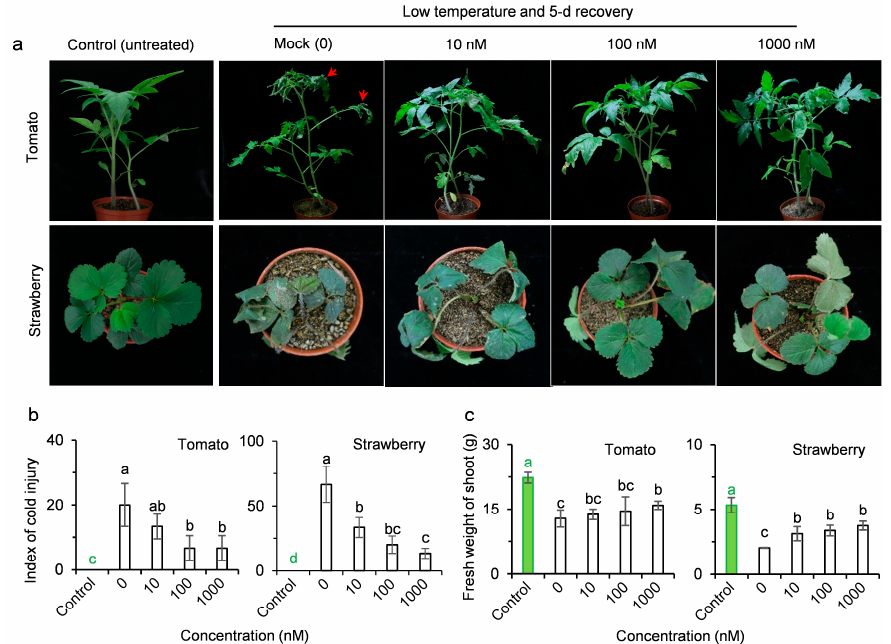
Figure 6. Induction of resistance to low temperature by AMHA in strawberry and tomato seedlings. After pretreatment with water containing 0.02% Tween-20 (mock) or different concentrations of AMHA (10, 100 and 1000 nM) supplemented with 0.02% Tween-20, tomato and strawberry seedlings were treated for 24 h at − 2 °C and for 12 h at − 4 °C, respectively, under 200 μ mol m − 2 s − 1 light and recovered at normal temperature for 5 d. Controls represent the untreated-plants always kept in normal growth condition. ( a ) Phenotypes of plants after low temperature treatment. Photographs were taken after recovery for 5 d. ( b ) Effect of AMHA pretreatment on the cold injury index of tomato and strawberry plants treated with low temperature. ( c ) Effect of AMHA pretreatment on the shoot fresh weight of tomato and strawberry plants treated with low temperature. Values are the means ± SD of four independent biological replicates. Different small letters above error bars indicate significance at 0.05 level.